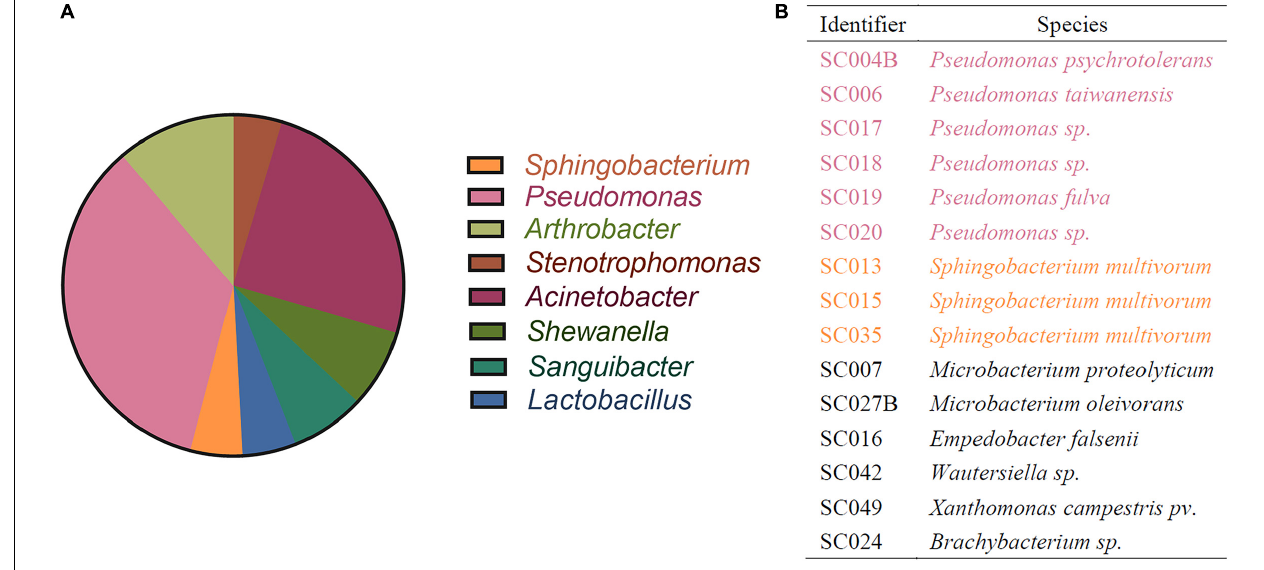
NC, EC, and SC042 ( Figure 3A ). Also, the reduction of